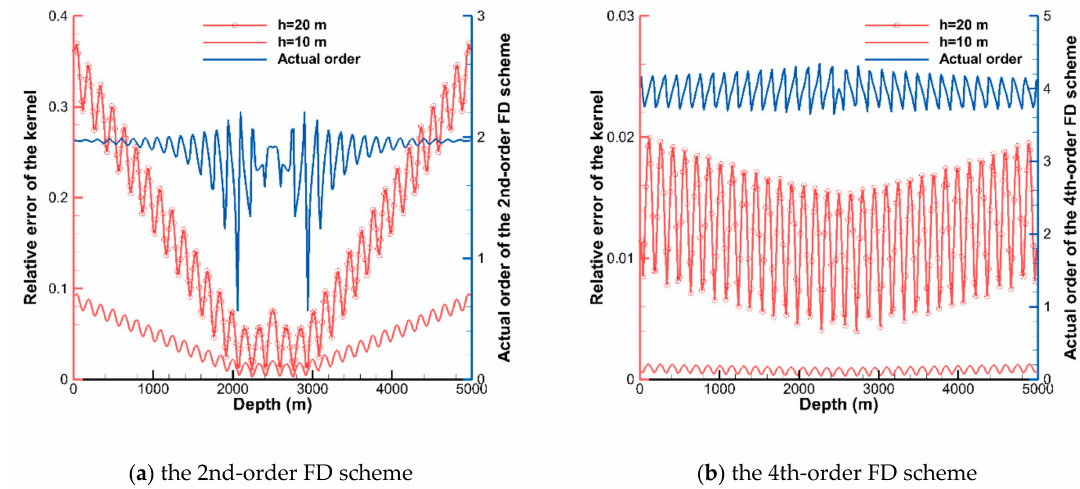
Figure 3. Relative errors of the kernel and actual orders of the FD schemes ( k r = k r ,1 ). Figure 4 shows the TL curves along the receiver line z = 20 m, where TL = − 20 log 10 | P | (in dB) and | P | denotes the magnitude of the complex pressure P . The solutions of the 2nd- and 4th-order FD schemes ( h = 20 m) match the exact analytical formula well in general, and the curve of the 4th-order FD scheme is closer to that of the exact formula than that of the 2nd-order FD scheme.